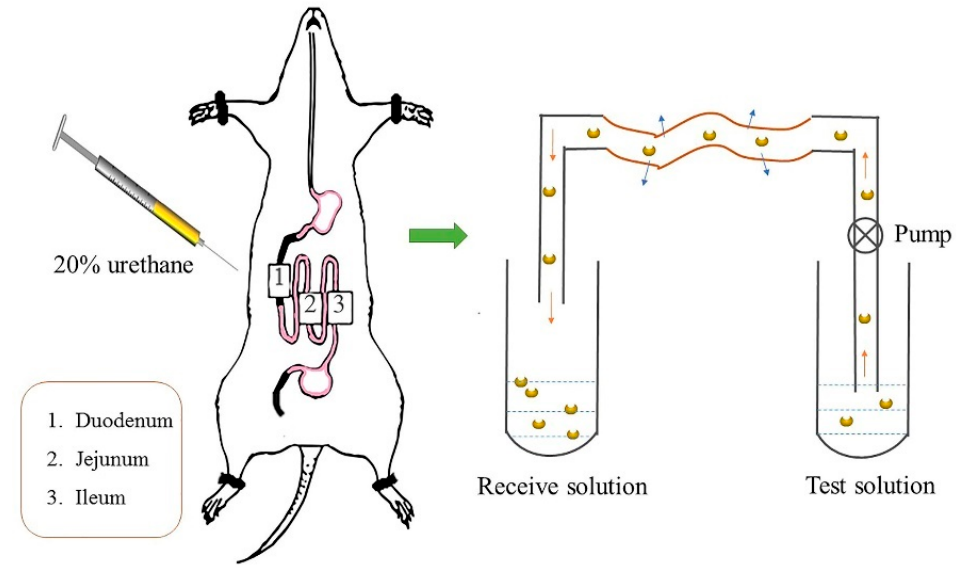
Figure 1. The schematic overview of the in situ intestine perfusion model.